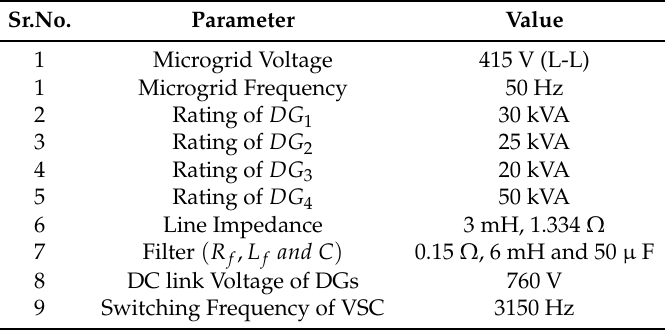
Table 1. The Microgrid